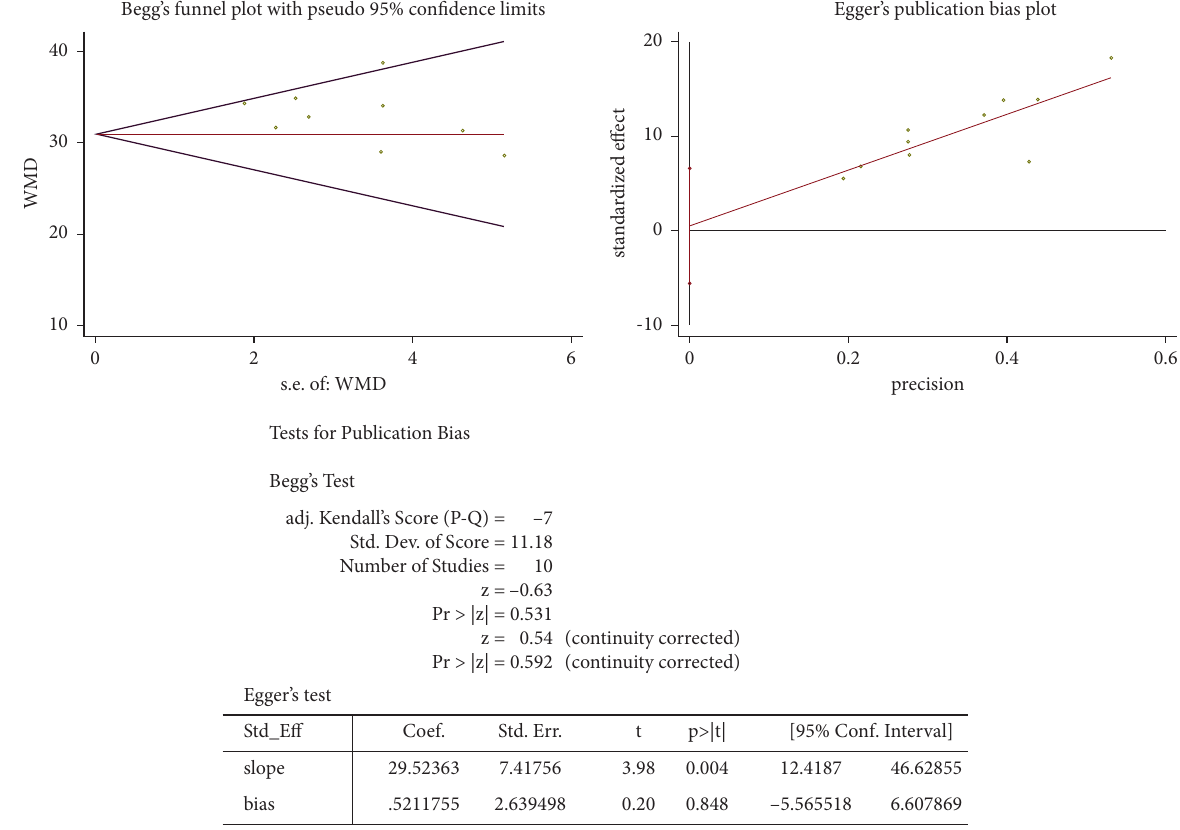
Figure 7: Publication bias analysis by Begg’s and Egger’s tests regarding the posterior-only